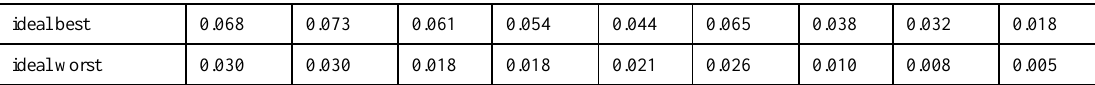
Table 6. Positive ideal solution (PIS) & negative ideal solution (NIS)